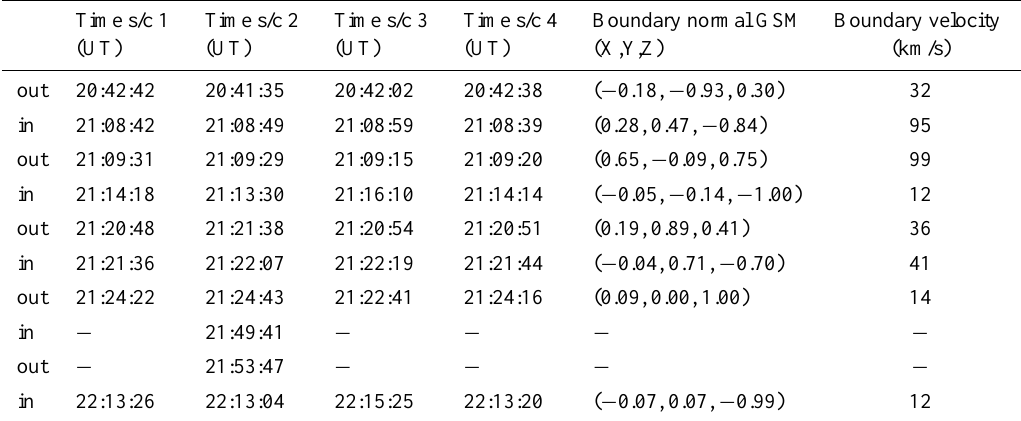
Table 1. Observations by PEACE. In the first column “out” refers to s/c motion out from the plasma sheet, and “in” a return into the plasma sheet.